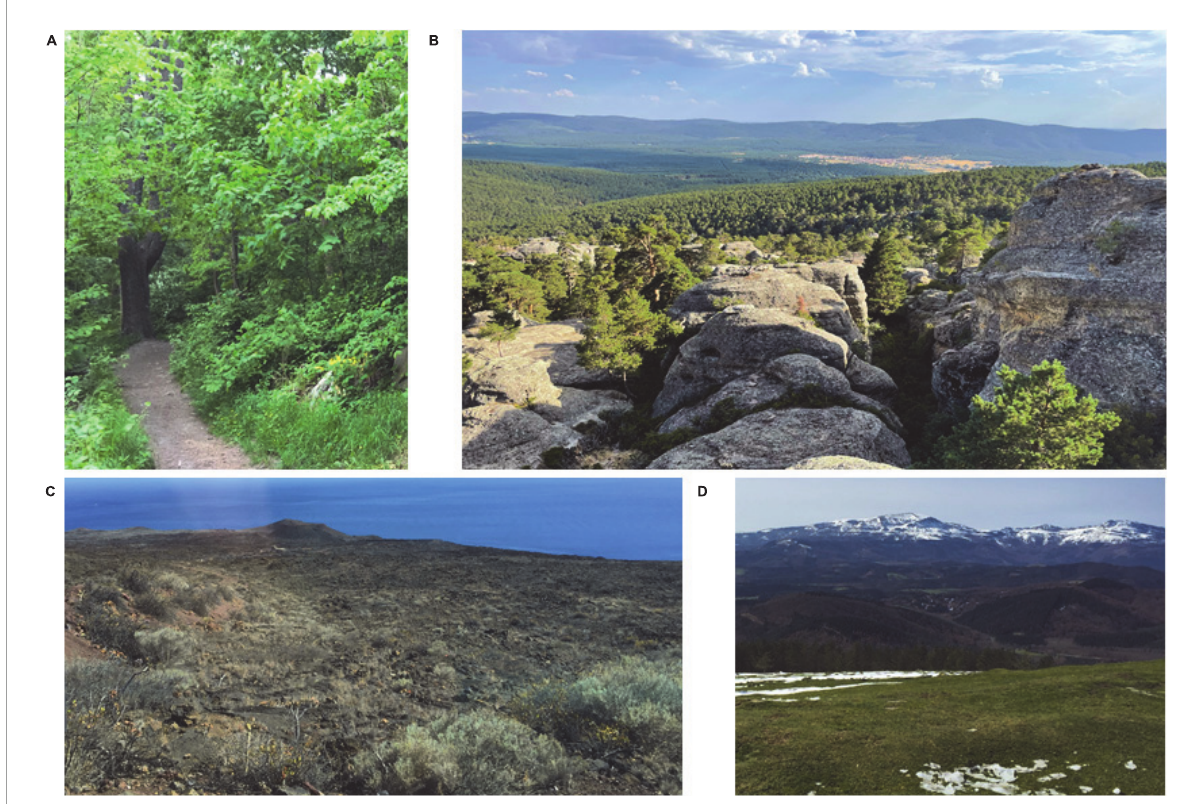
FIGURE1 Examples of green scenes that could lead to plant blindness. (A) A green scene where all vegetation (grasses and trees) show a similar shade of green. (B) A vast pine forest from a distance forming a more or less homogeneous green view. (C) An arid ecosystem with soil and vegetation being hard to differentiate at a given distance. (D) A winter view with green, brown and white patches from a distance. All photos were taken by the author in